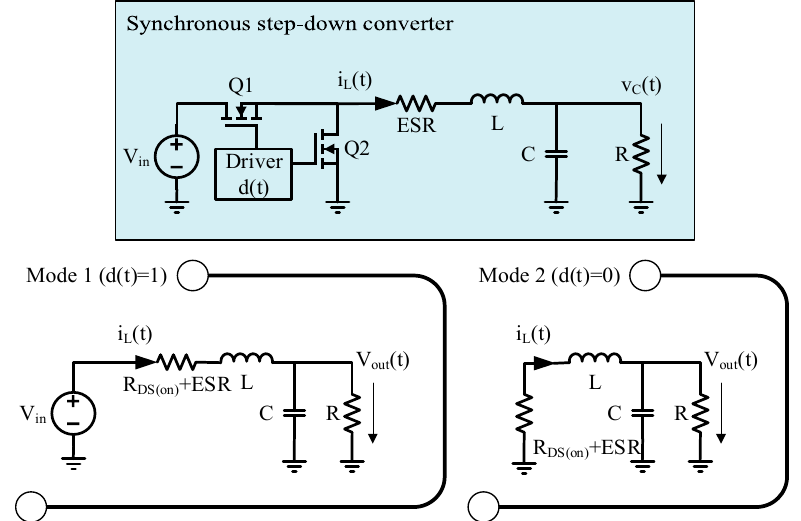
Figure 4. Synchronous step-down (buck) converter model with parasitic components and its operating modes.